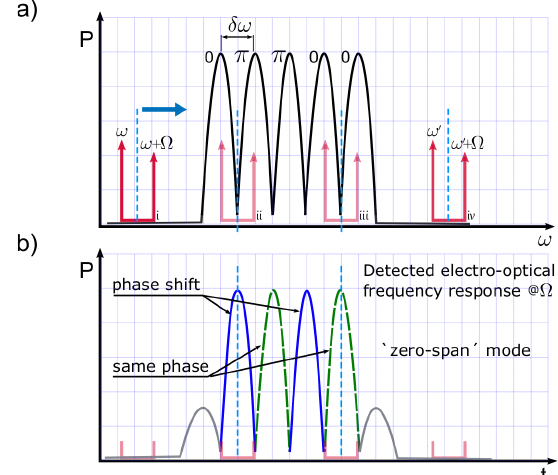
Figure 1. Illustration of the interrogation method used to retrieve the frequency response of the sensing network in phase and amplitude. In ( a ), the dual-wavelength source scanning process is depicted; ( b ) depicts the electro-optical frequency response for the sensing device; amplitude and phase response from the sensing array are